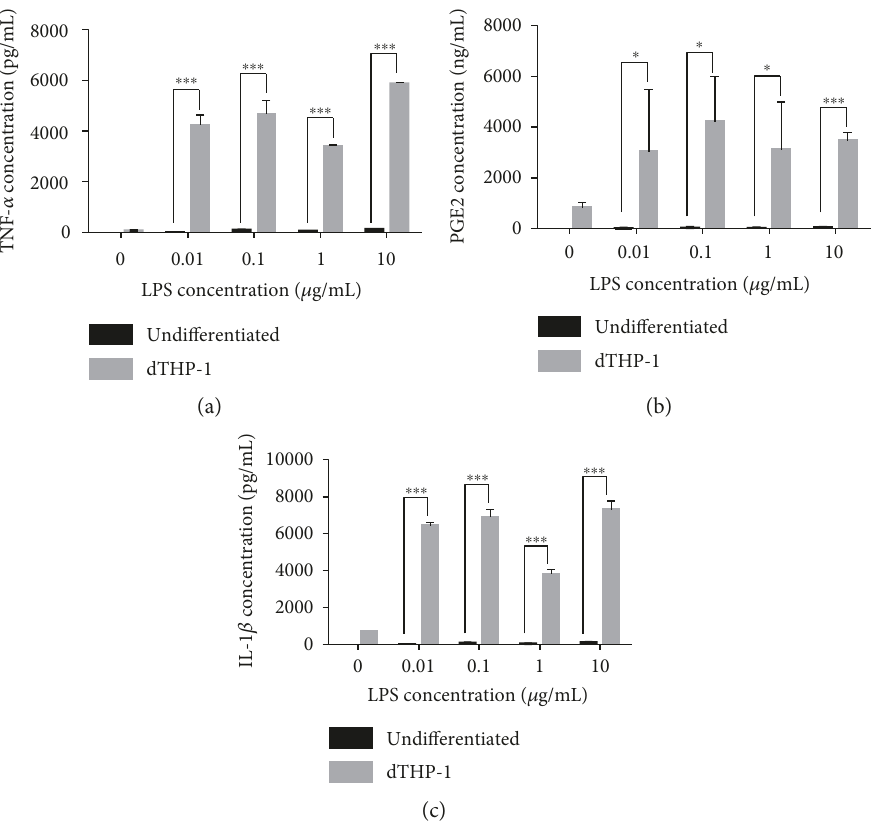
Figure 1: Veri fi cation of proin fl ammatory mediator release following LPS activation of di ff erentiated THP-1 (dTHP-1) cells. Cells were treated with LPS (0 – 10 μ g/mL) for 24h, following the release of (a) TNF- α , (b) PGE2, and (c) IL-1 β which were measured by ELISA. Data shows mean +SD of three independent